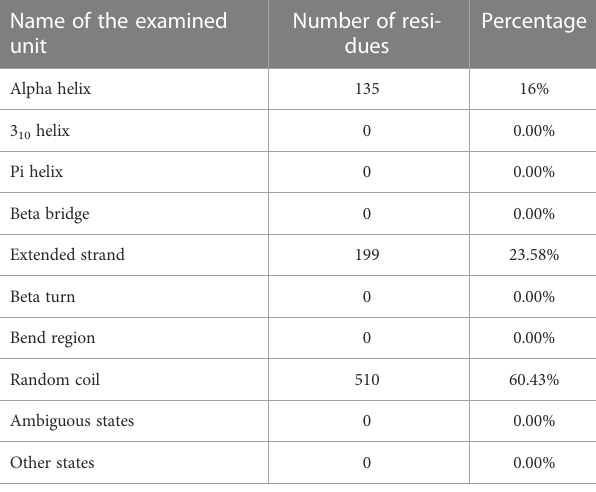
TABLE 8 Results of the study of the second structure of the determined